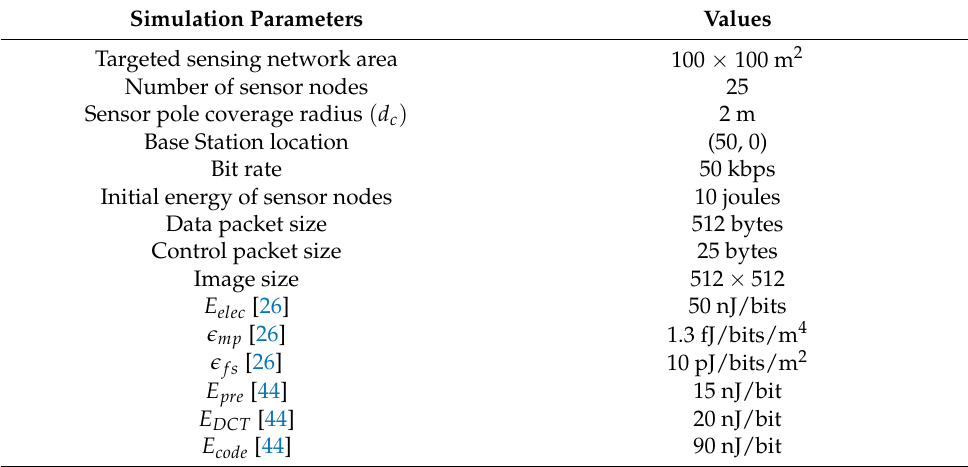
Table 3. Simulation